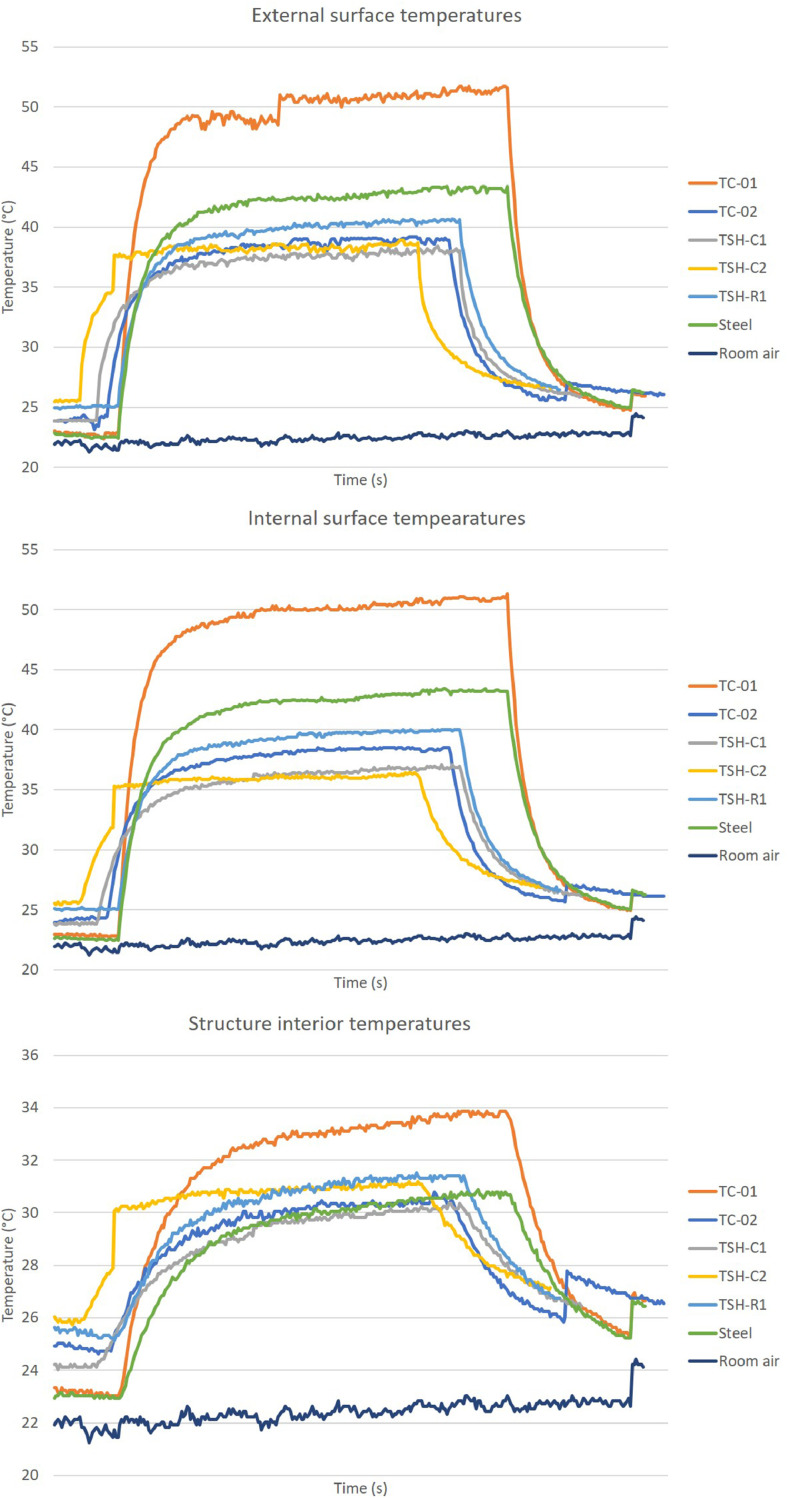
60 cm/no airflow.